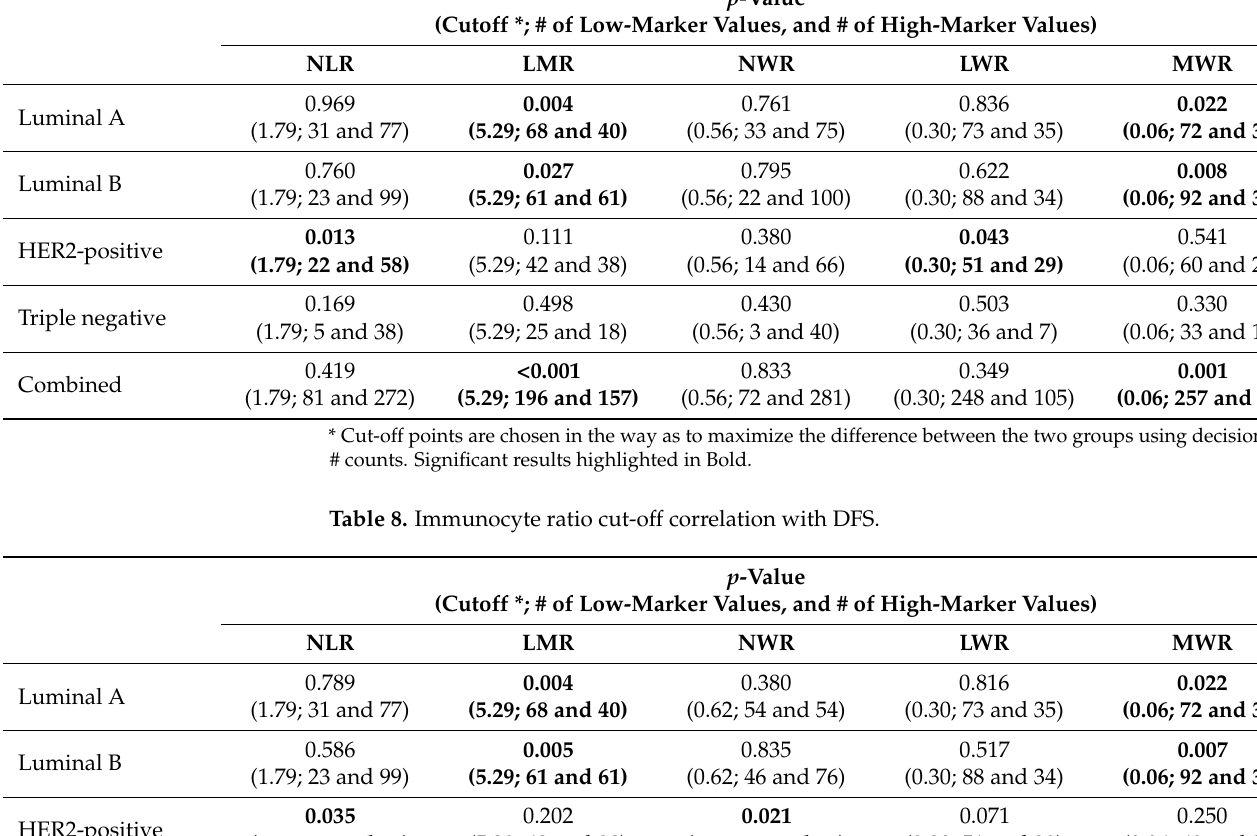
Table 7. Immunocyte ratio cut-off correlation with OS.